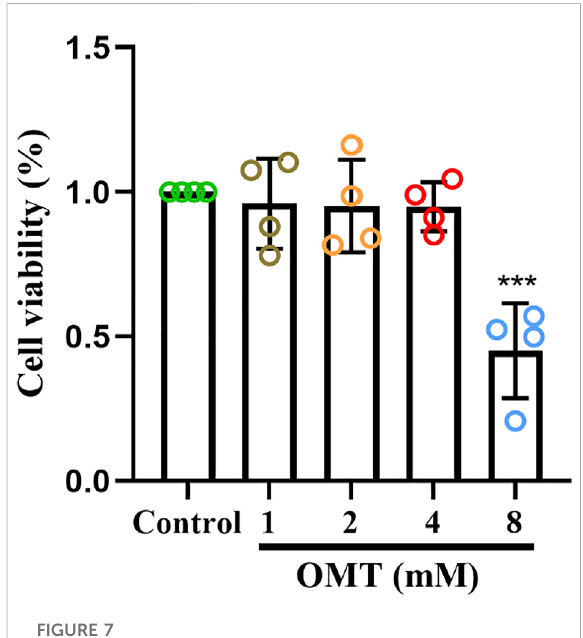
FIGURE 7 The effect of OMT on the viability of RAW264.7 cells. Cytotoxic effect of various concentrations of OMT (0, 1, 2, 4, and 8 mM) on RAW264.7 cells after 24 h examined by using the CCK8 assay. Values represent average + S.U. Signi fi cant differences among different groups am indicated as *** p < 0.001 vs. control group.